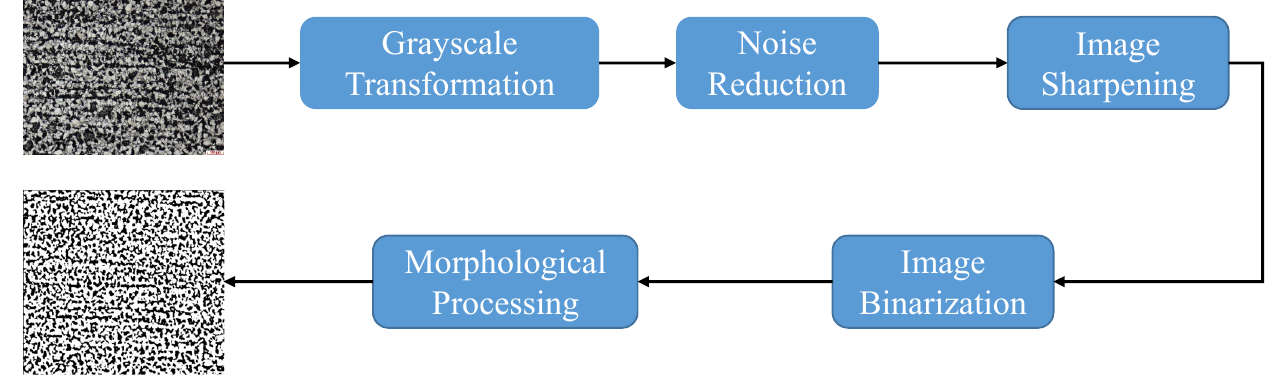
Figure 7. The pipeline of image preprocessing for morphological